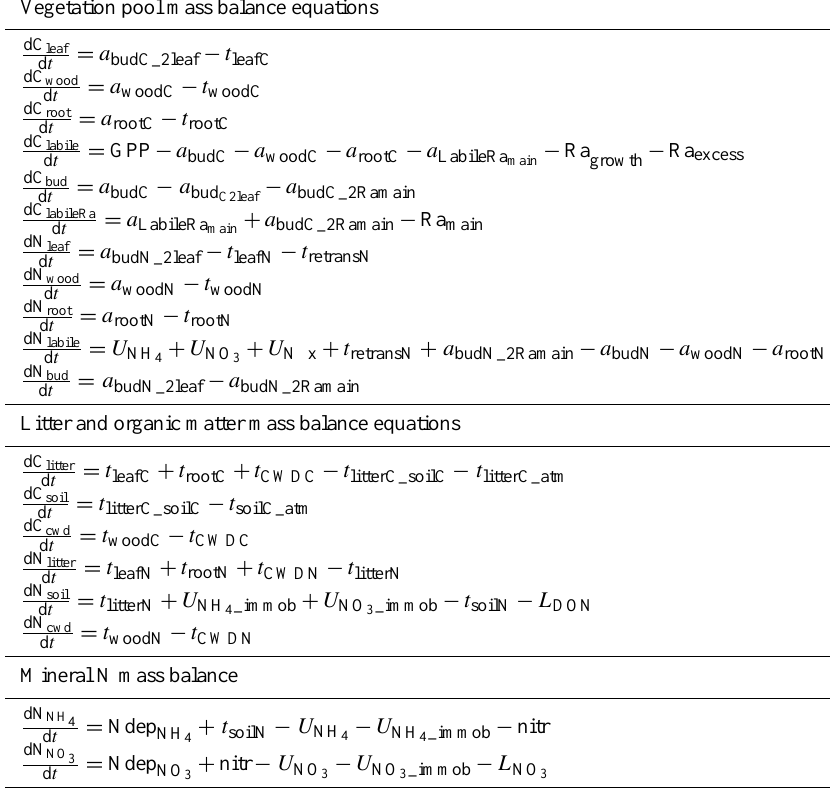
Table 1. Mass balance equations used in ACONITE. Vegetation pool mass balance